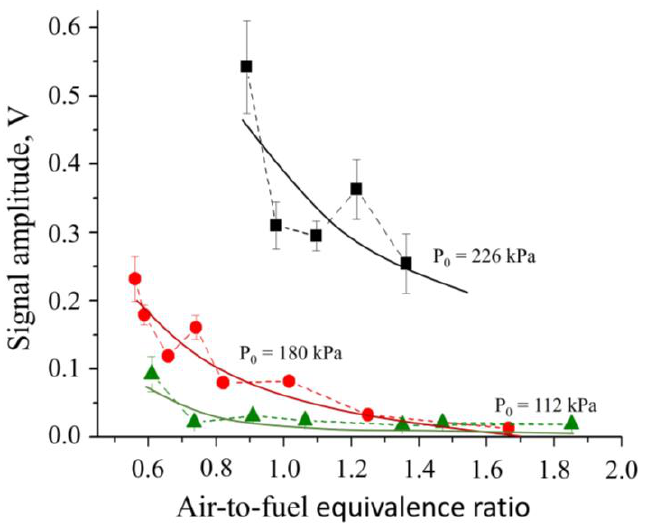
Figure 18. The signal amplitude of the ion sensor vs. the air-to-fuel equivalence ratio in the RDE combustor at different values of total pressure. Solid lines approximate experimental